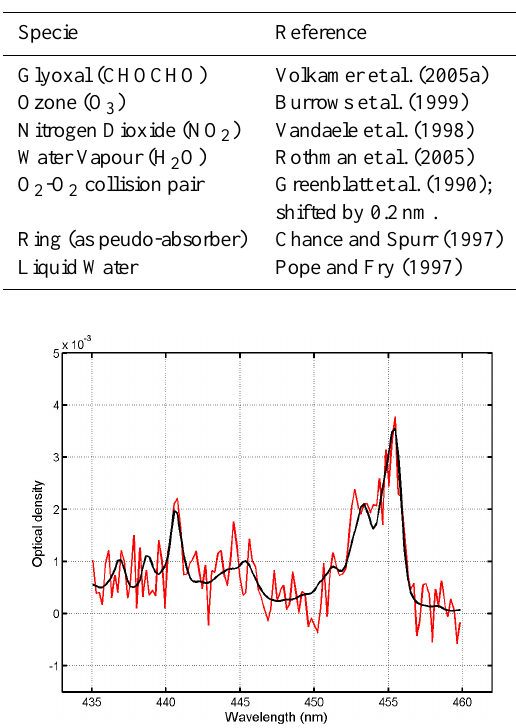
Fig. 1. DOAS fit of the glyoxal optical density for a GOME-2 measurement recorded on 16 March 2007 close to Hanoi (Viet- nam). The black curve represents the reference glyoxal cross- section scaled by the fitted SCD (6.57 × 10 15 molec/cm 2 ). The red curve represents the fit residuals superimposed to the glyoxal opti- cal density.